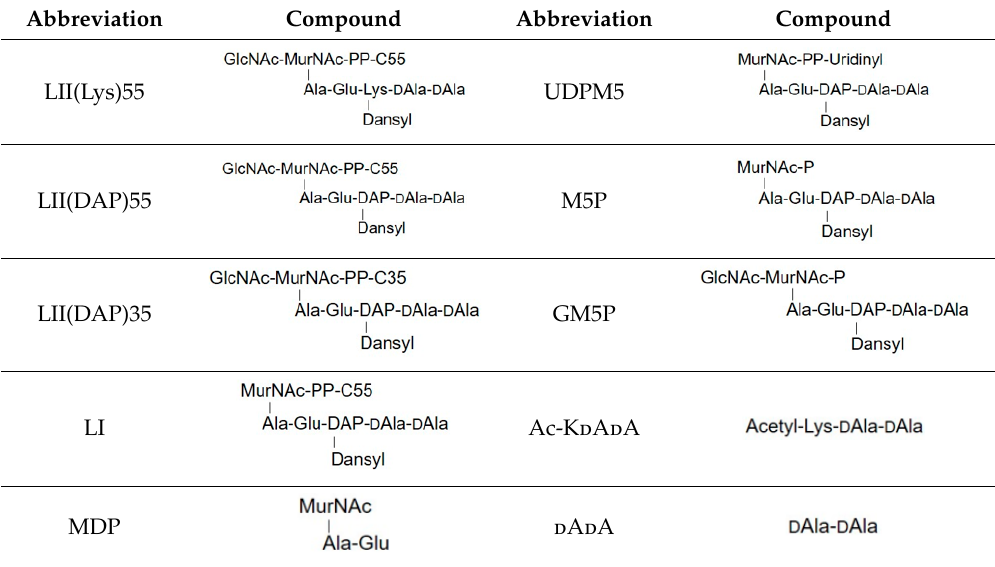
Table 1. Bacterial lipid I and II analogs and fragments used in this